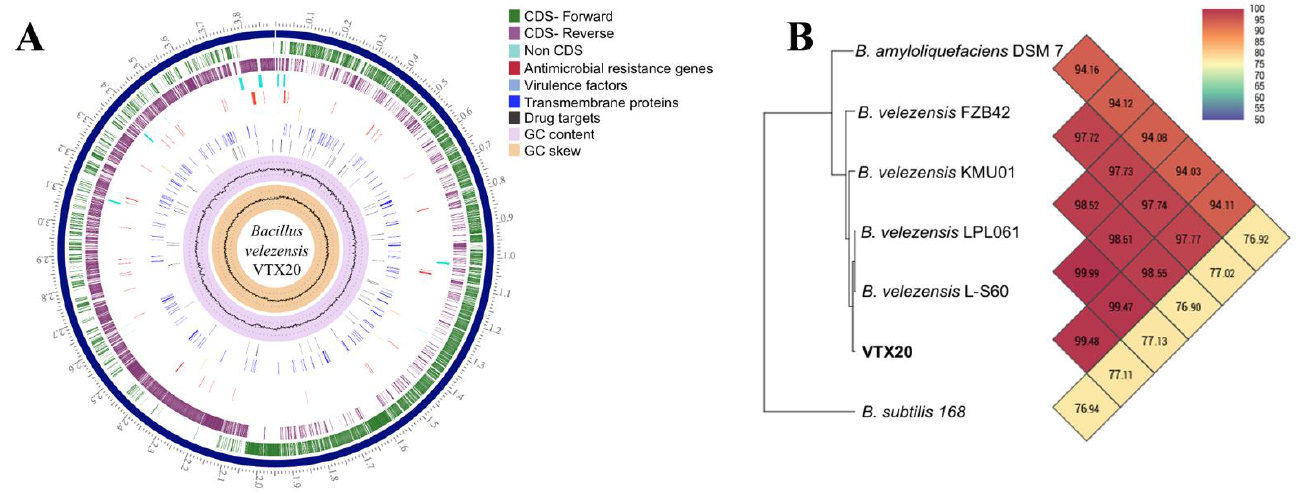
Figure 3. Circular map ( A ) and heat map ( B ) based on OrthoANI values determined for B. velezensis VTX20 and related strains.